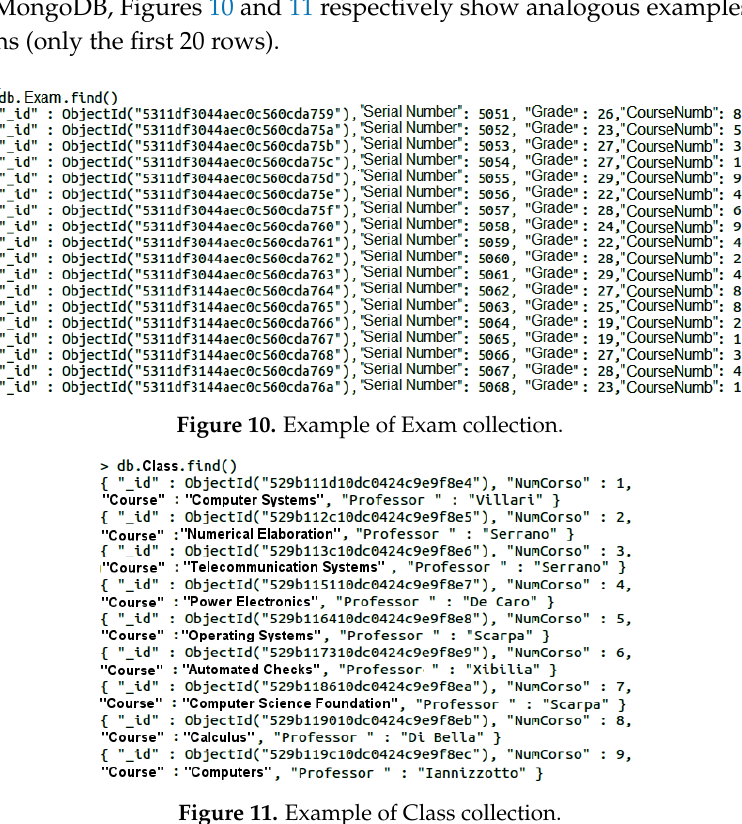
Figure 11. Example of Class